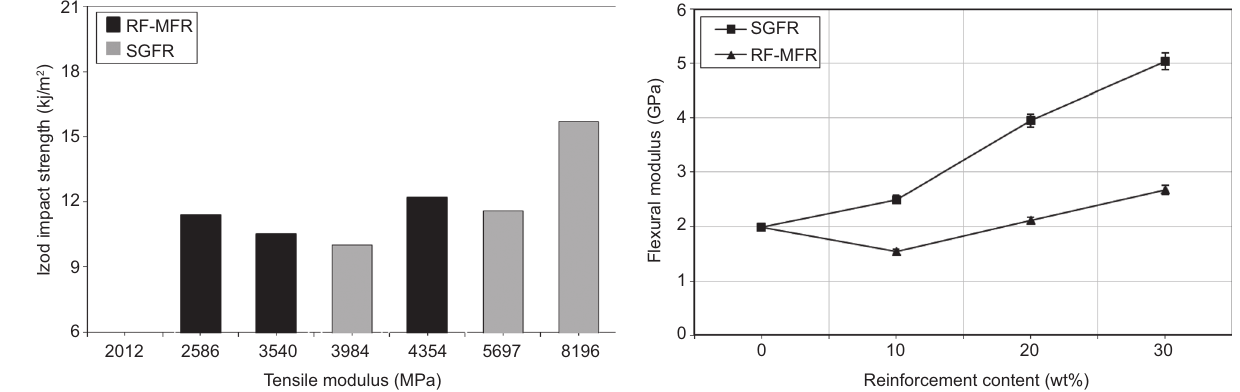
Figure 5 Variation of the notched Izod impact strength of PA6 with tensile modulus of composite.